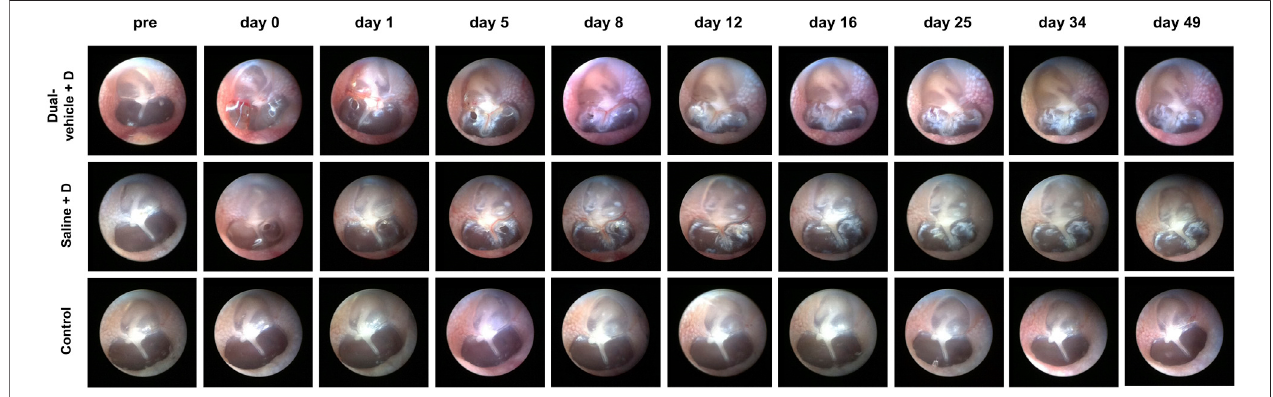
FIGURE2| Tympanicmembrane(TM)endoscopyafterintratympanic(IT)drugdelivery.TwosmallperforationsweremadeduringITdrugdelivery.Theperforations healed well in all ears after 18.4 ± 7.3 and 13.2 ± 7.8 days in the dual-vehicle + D and saline + D groups, respectively. There were no signs of in fl ammation or infection in any of the ears. No IT intervention was performed in the control